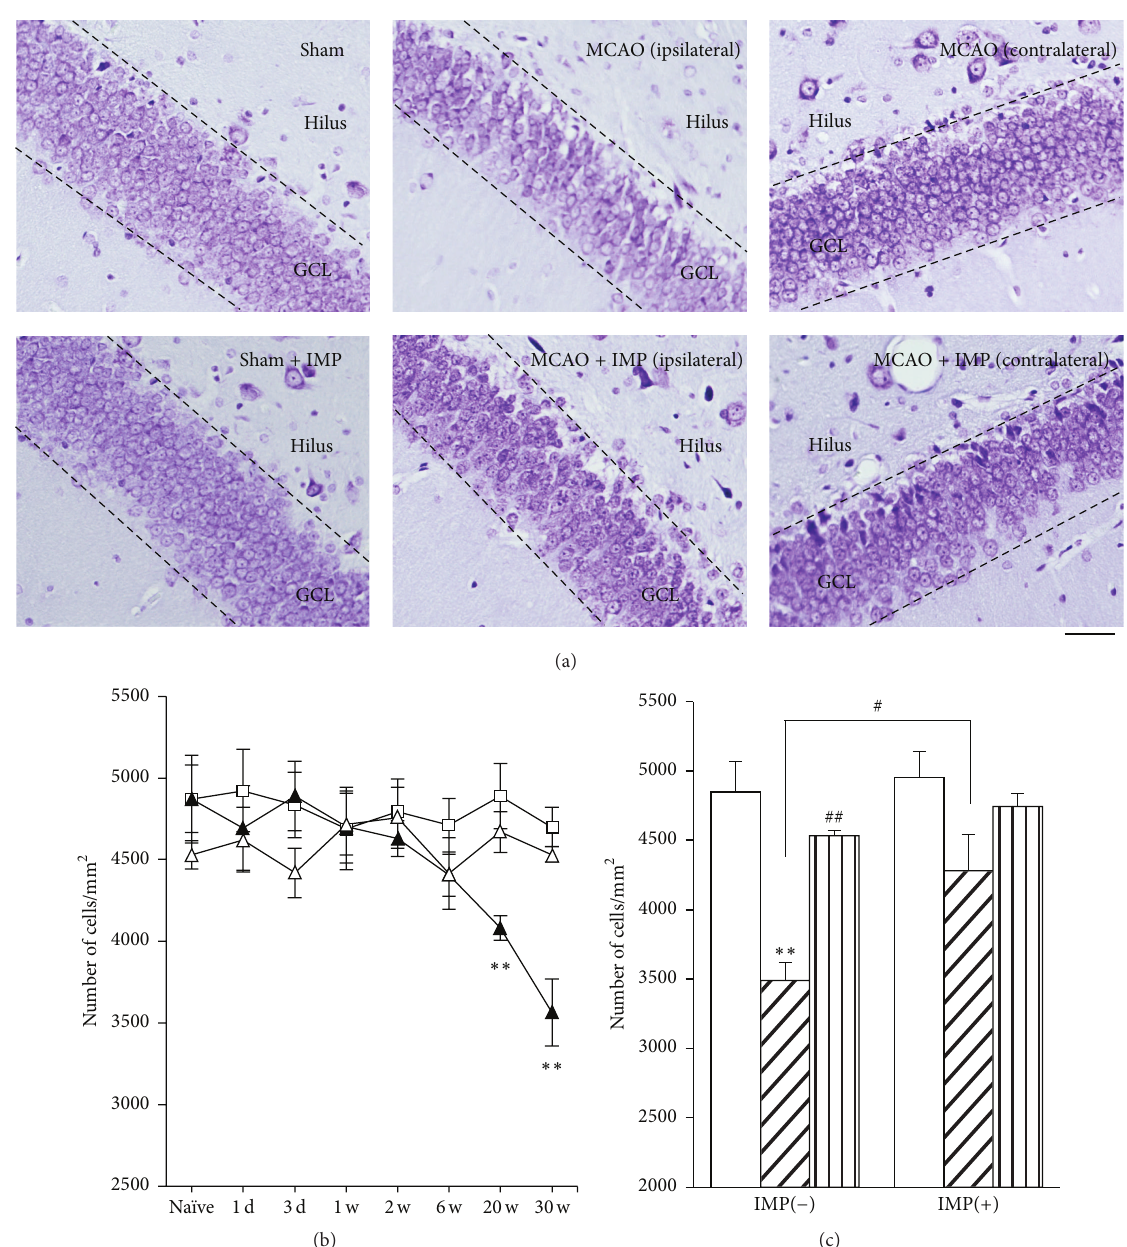
Figure 3: Analysis of the cresyl violet-stained cells in GCL. (a) Typical images of the slices taken at 30 weeks after MCAO. Scale bar indicates 50 𝜇 m. (b) Time course changes of Nissl positive cells after MCAO in GCL. Symbols used are as follows: open square, sham; closed triangle, ipsilateralMCAO;opentriangle,contralateralMCAO.Statisticalsignificancewasevaluatedwithtwo-wayANOVAfollowedbyTukey-Kramer = 2.96 ; 𝐹 = 7.37 ; 𝐹 = 2.42 ; ∗∗ 𝑃 < 0.01 versus sham). (c) Analysis of the effect of test at each time point ( 𝐹 ( ( group )2 ( time ∗ group )14,96 time )7 IMP on the number of Nissl positive cells at 30 weeks after MCAO. Open columns, sham; hatched columns, ipsilateral MCAO; striped columns, contralateral MCAO. Vehicle [IMP( − )] or 20mg/kg/day of IMP for 29 weeks [IMP(+)] from 1 week after the surgical operation was administered. Statistical significance was evaluated with one-way ANOVA followed by Tukey-Kramer test ( 𝐹 5,24 = 8.78 ; ∗∗ 𝑃 < 0.01 versus sham [IMP( − )]; # 𝑃 < 0.05 and ## 𝑃 < 0.01 versus ipsilateral MCAO; 𝑁 = 5 /group).